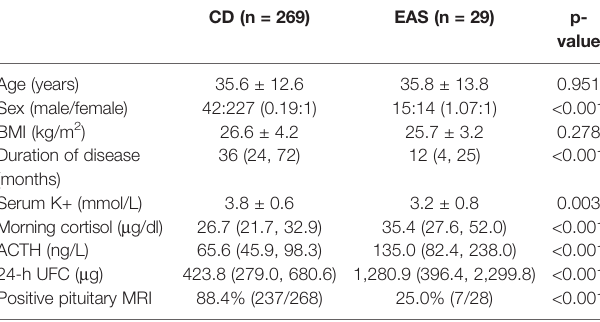
TABLE 1 | Clinical characteristics of patients with CD and